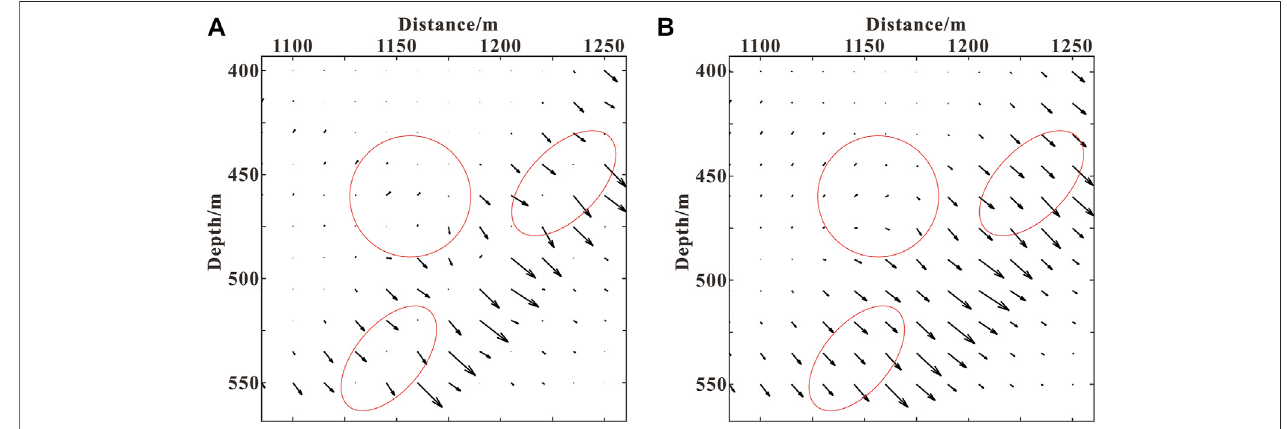
FIGURE 3 | The wave fi eld direction near the re fl ection interface calculated: (A) based on the Poynting vector; (B) based on the optical fl ow vector.